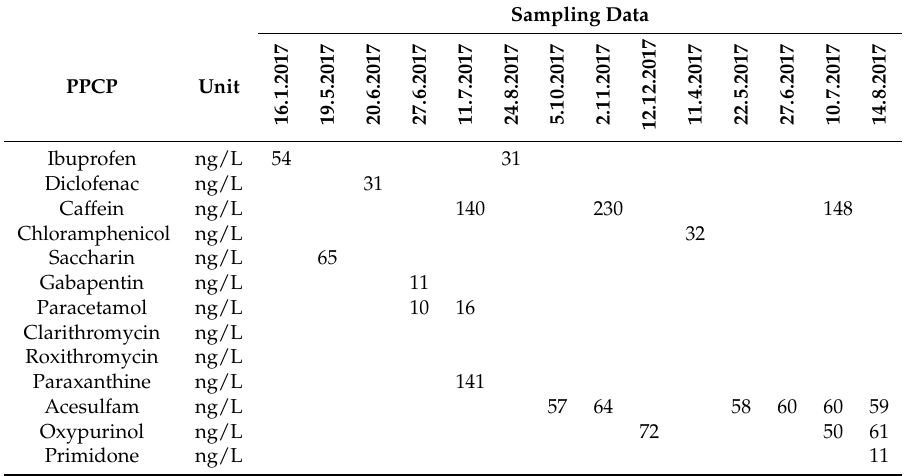
Table 2. An overview of PPCPs in a mixed sample of bank infiltration (the table shows only the observed time periods when at least one substance was found above the detection